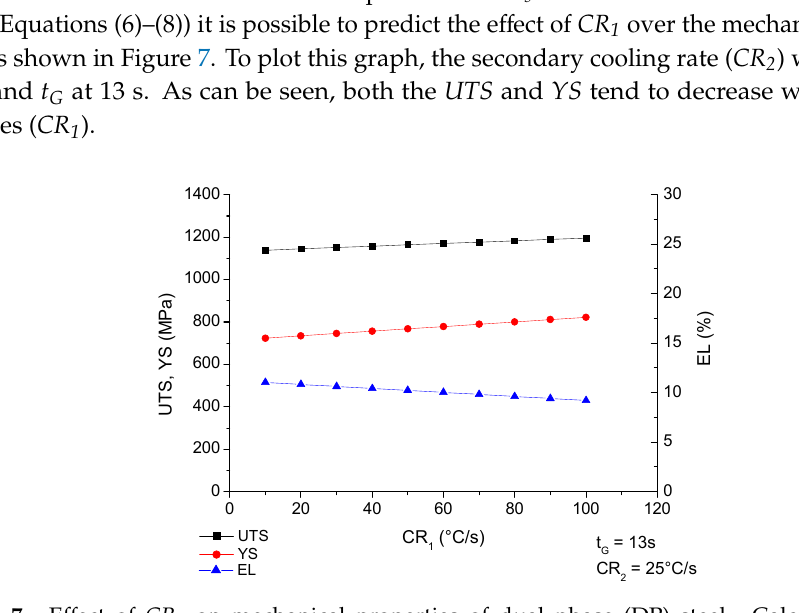
Figure 6. Microstructure of TVF-3 heat treated sample: ( a ) 2500 × and ( b ) 10,000 × ; B: Cainite; α : Ferrite and α ’: Martensite.